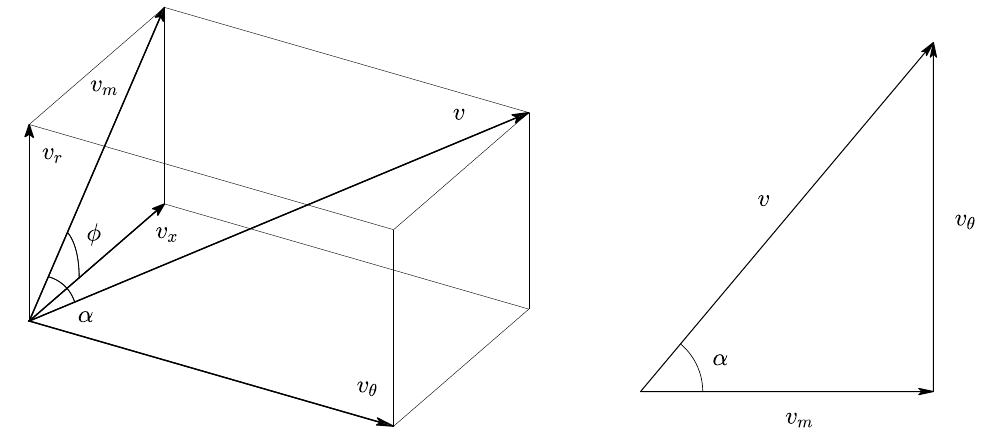
Figure 2. Decomposition of the velocity